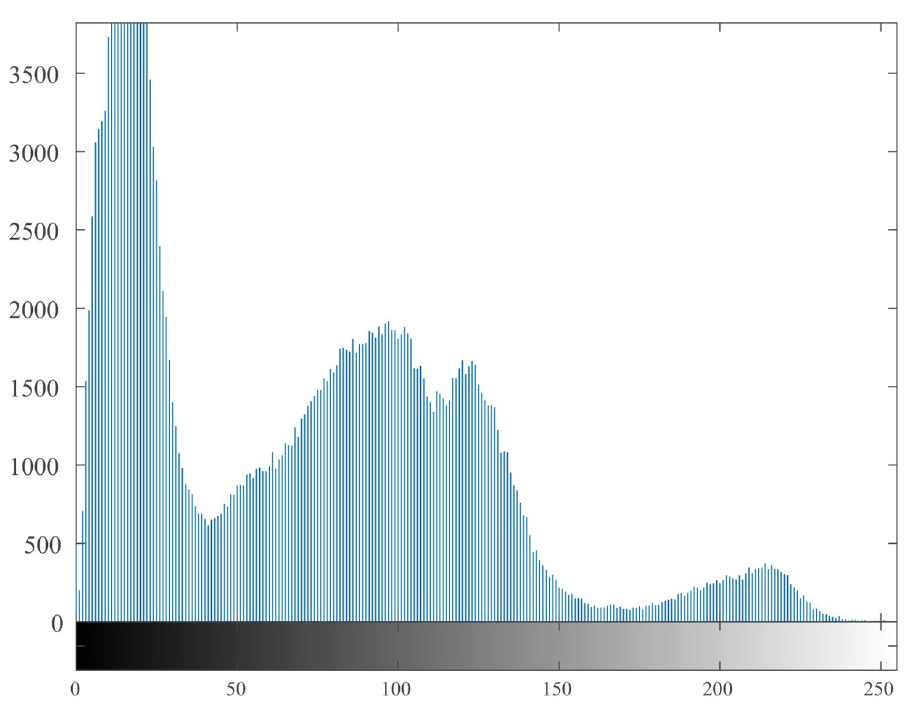
Fig 9. Histogram of the original